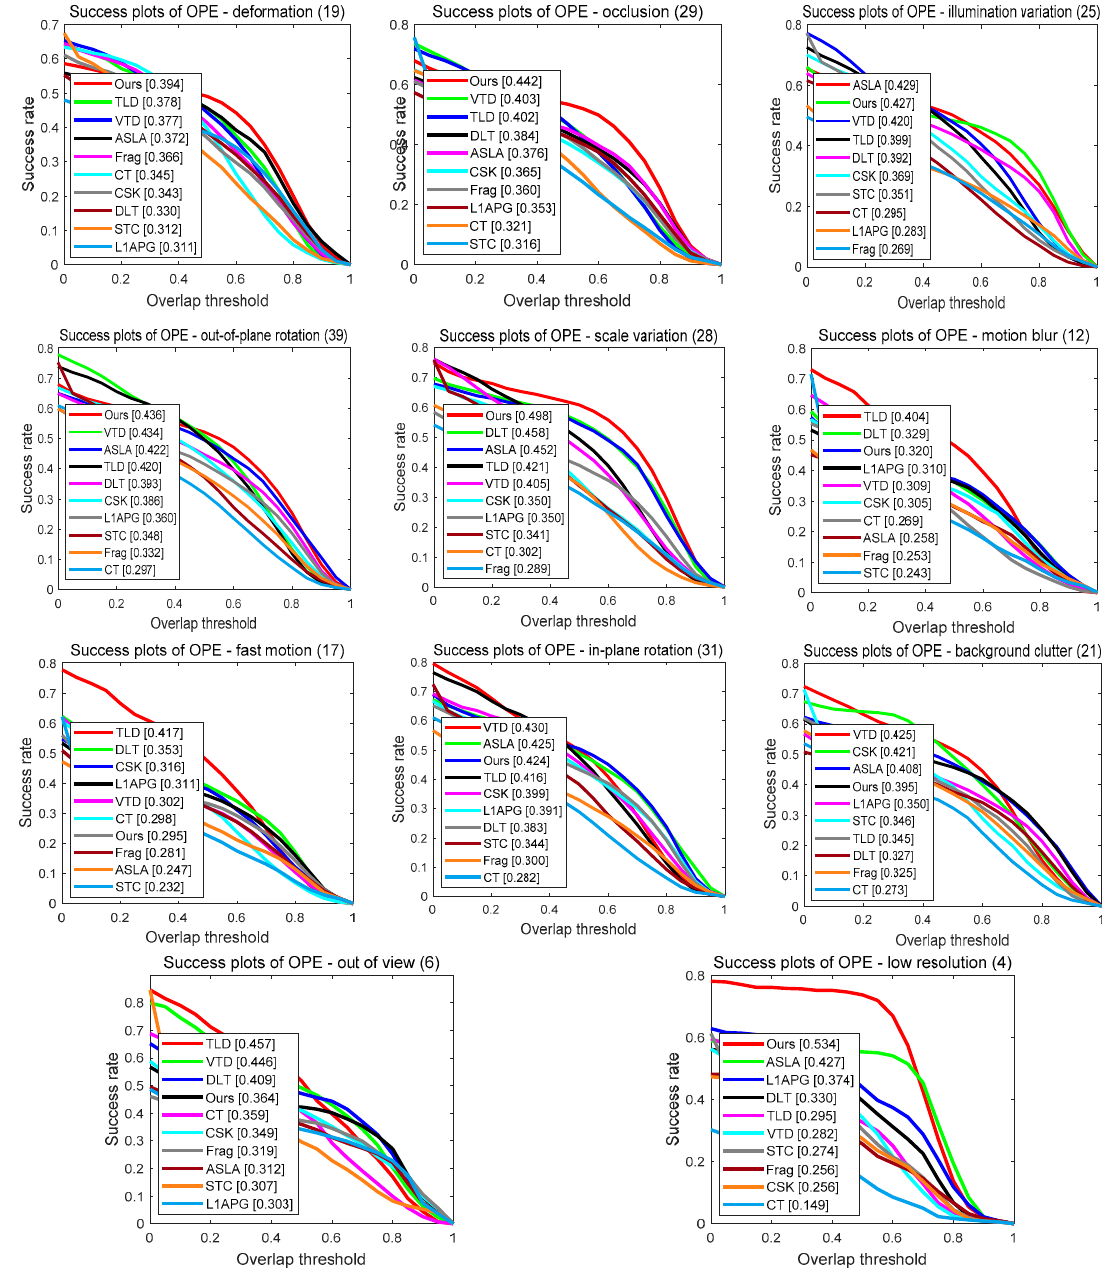
Figure 6. Success plots for different attributes. The legend contains the AUC score of each tracker.